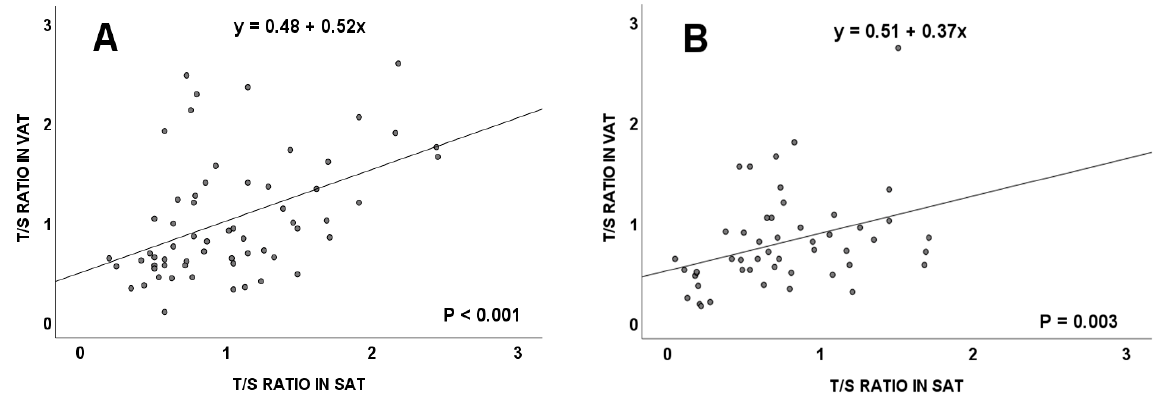
Figure 3. Telomere length (measured as T/S ratio) correlation between visceral and subcutaneous adipose tissues in colorectal cancer patients ( A ), and in subjects without colorectal cancer ( B ). VAT: visceral adipose tissue; SAT: subcutaneous adipose tissue.